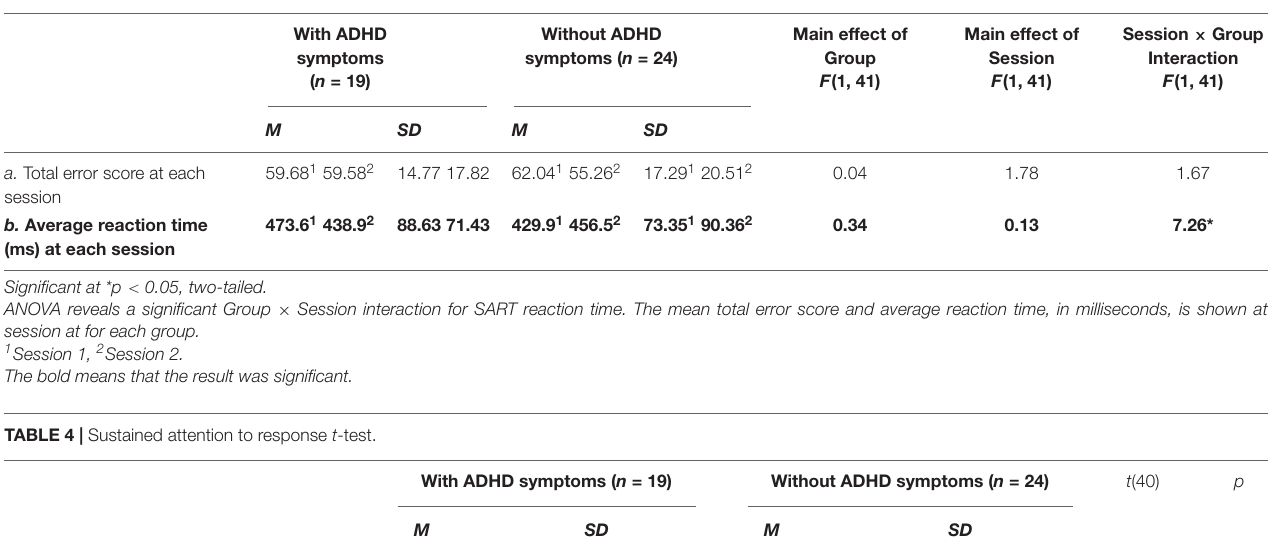
TABLE 3 | Sustained attention to response task analysis of variance.